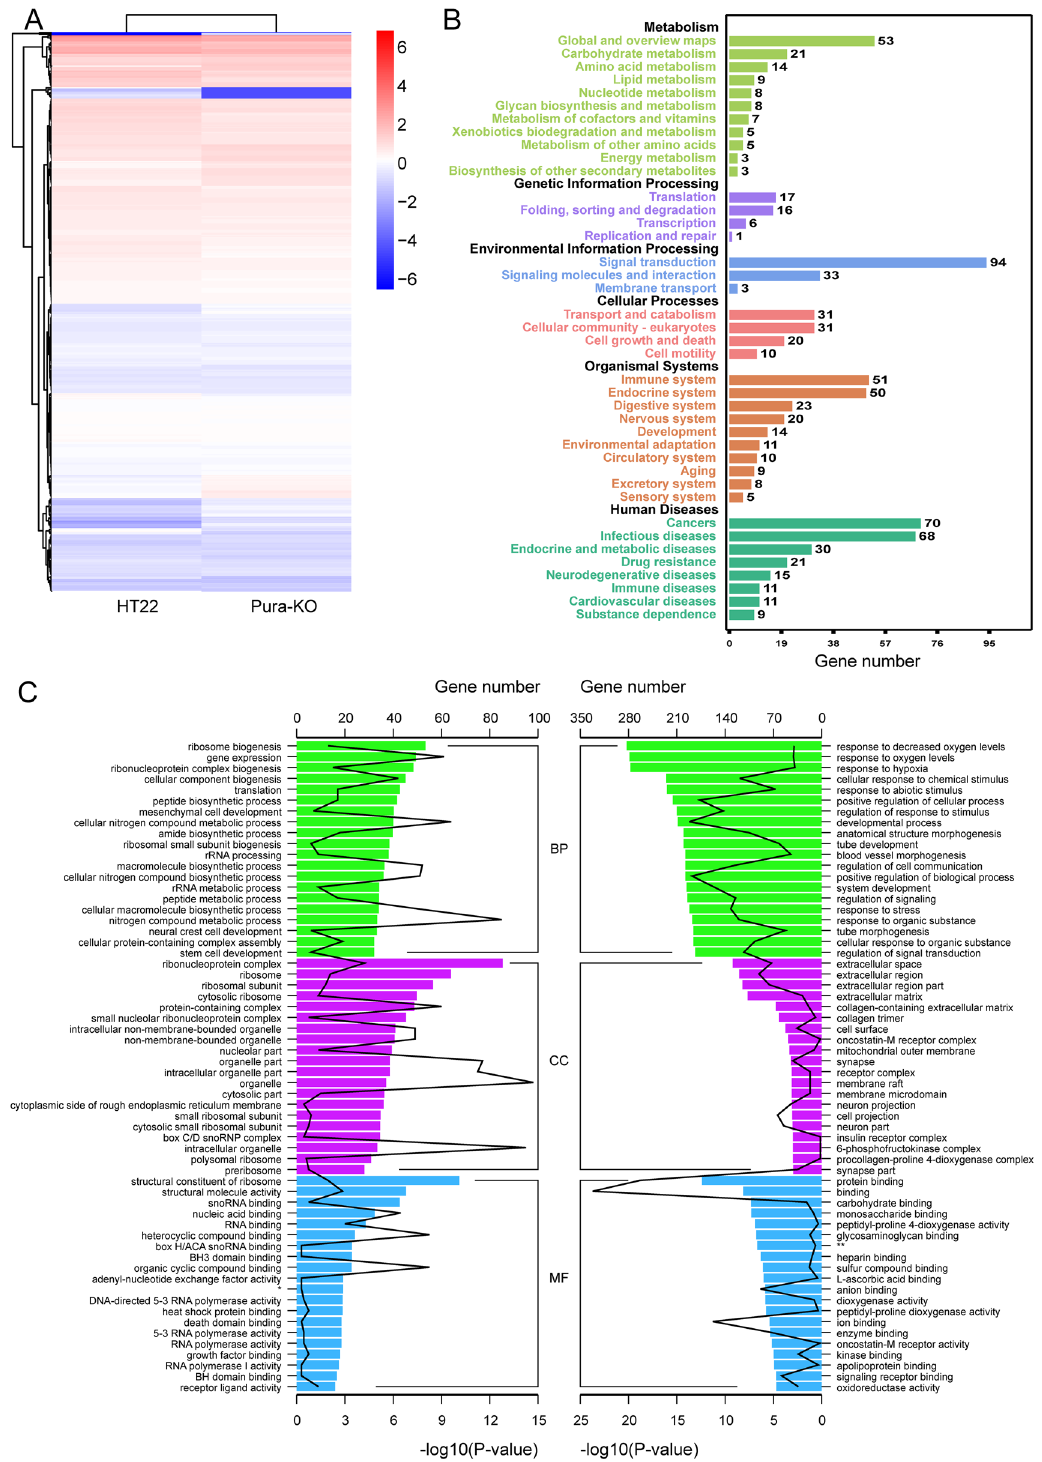
Figure 1. Differential gene enrichment analysis. ( A ) The difference between the differential genes in the HT22 group and the Pur ɑ -KO group is shown in the form of a heat map. ( B ) Histogram results of KEGG enrichment analysis of differential genes. The abscissa is the number of genes and the ordinate is the enrichment result. ( C ) GO enrichment of differential genes. The left aspect is the result of up-regulated gene enrichment and the right represents down-regulation. *RNA polymerase II sequence-specific DNA-binding transcription factor binding. **oxidoreductase activity, acting on paired donors, with incorporation or reduction of molecular oxygen, 2-oxoglutrate as one donor, and incorporation of one atom each of oxygen into both